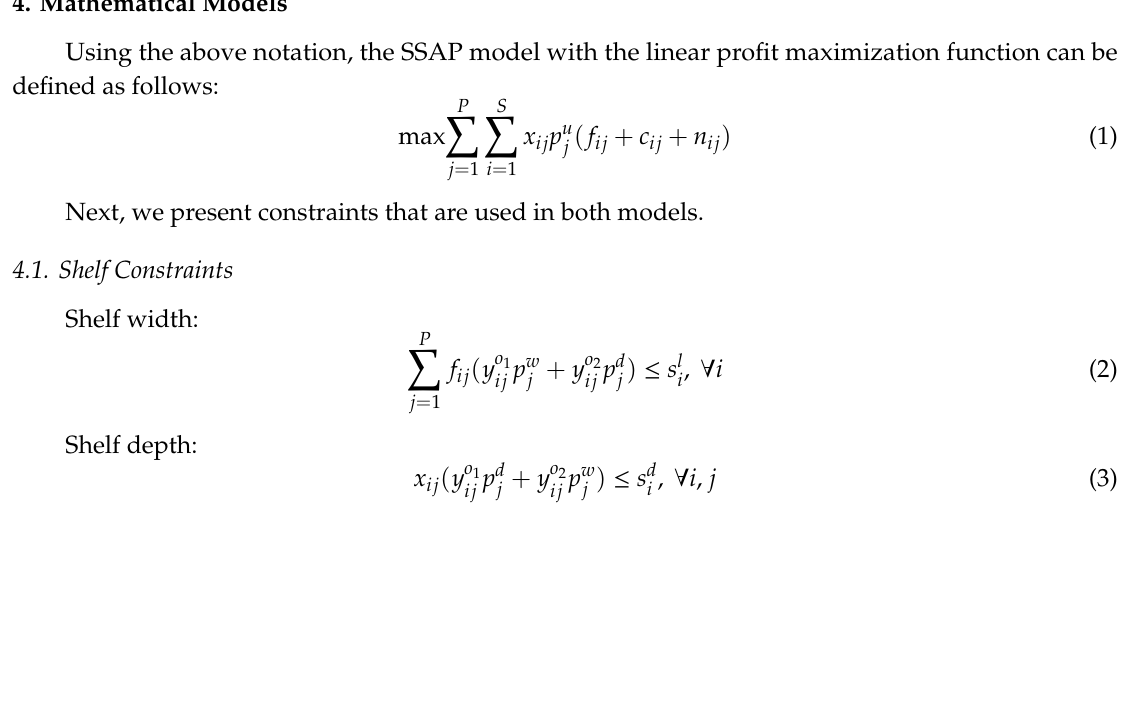
Figure 4. Allocation of nests.